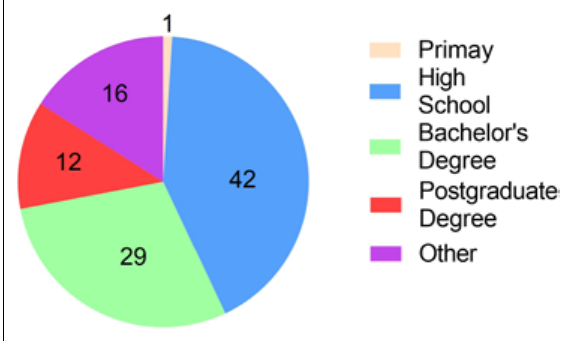
Figure 5. Education qualification distribution of respondents (percent).